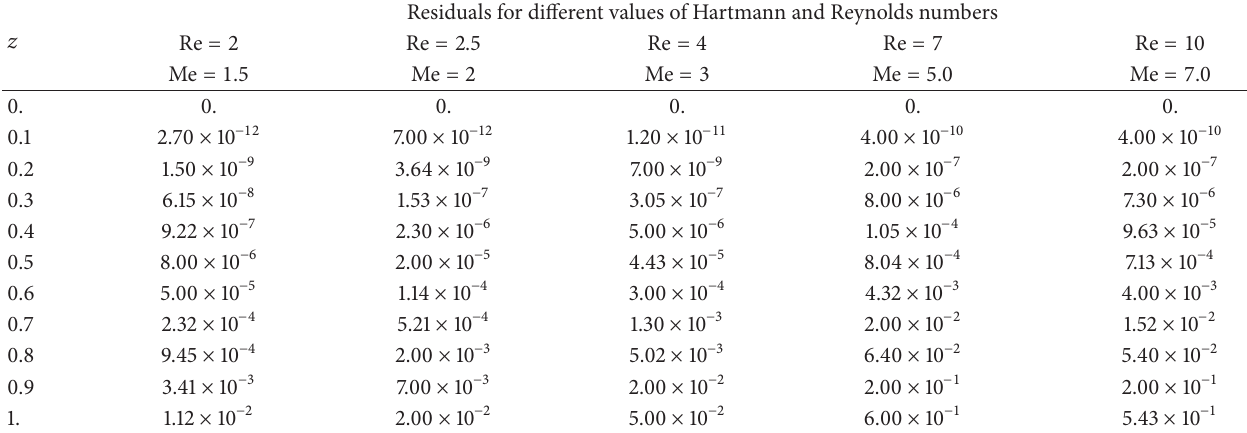
Table 4: Absolute residuals for different values of Me and Re with Re > Me keeping 𝛾 fixed.